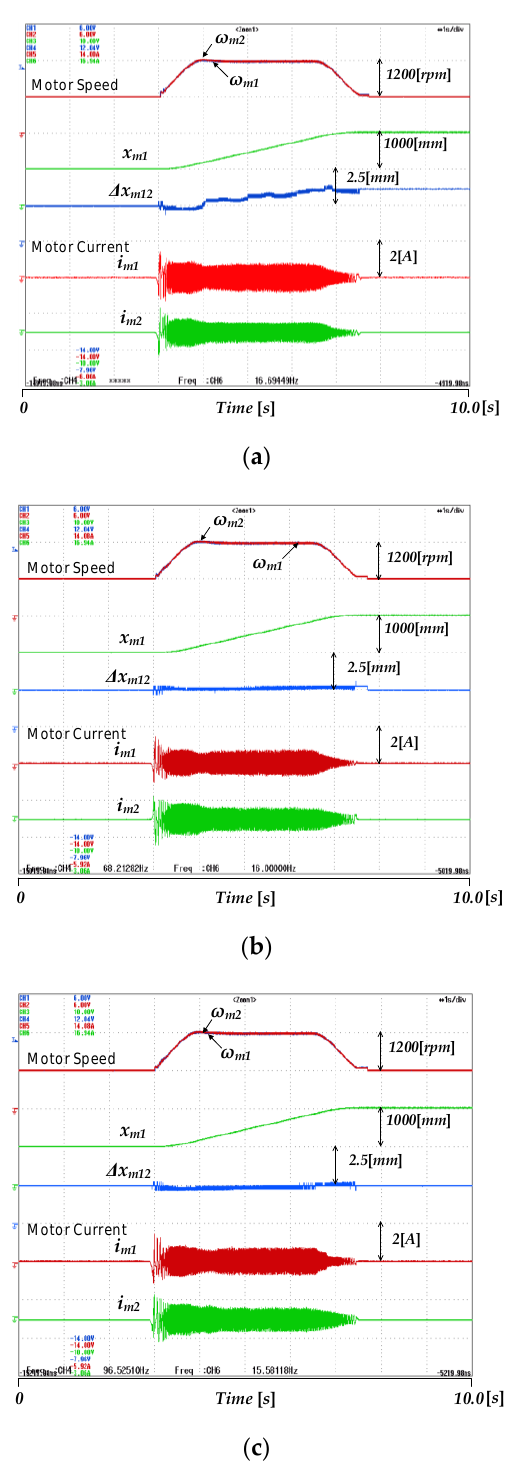
Figure 12. Experimental result in no-load condition: ( a ) Conventional position control method; ( b ) Balancing position control method; ( c ) Proposed control method.